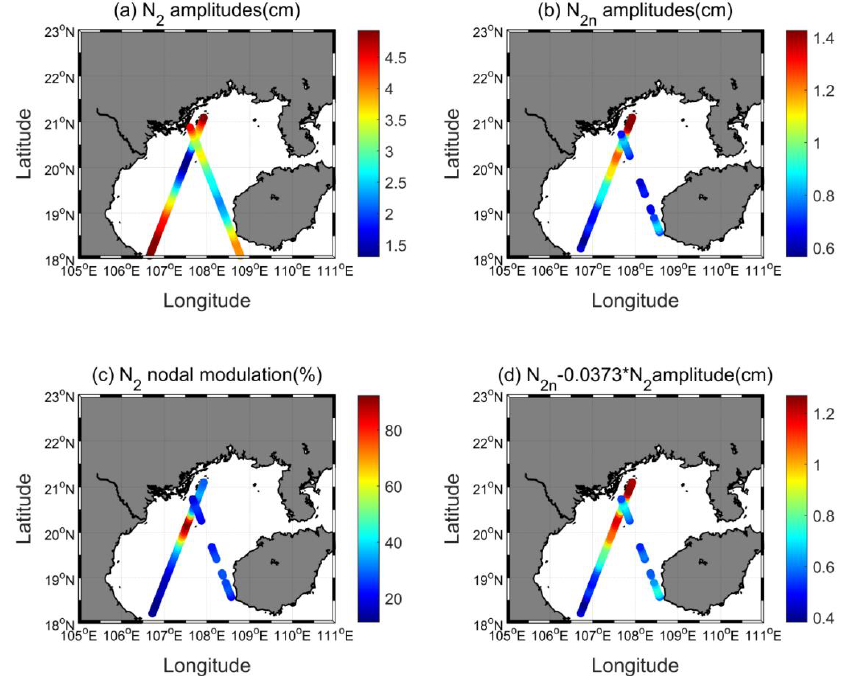
Figure 8. Estimated nodal amplitudes and nodal modulations from T/P-Jason observations in the Gulf of Tonkin: ( a ) N 2 amplitudes, ( b ) N 2n amplitudes, ( c ) N 2 nodal modulations, ( d ) the difference of theoretical and estimated N 2n amplitudes in the Gulf of Tonkin.